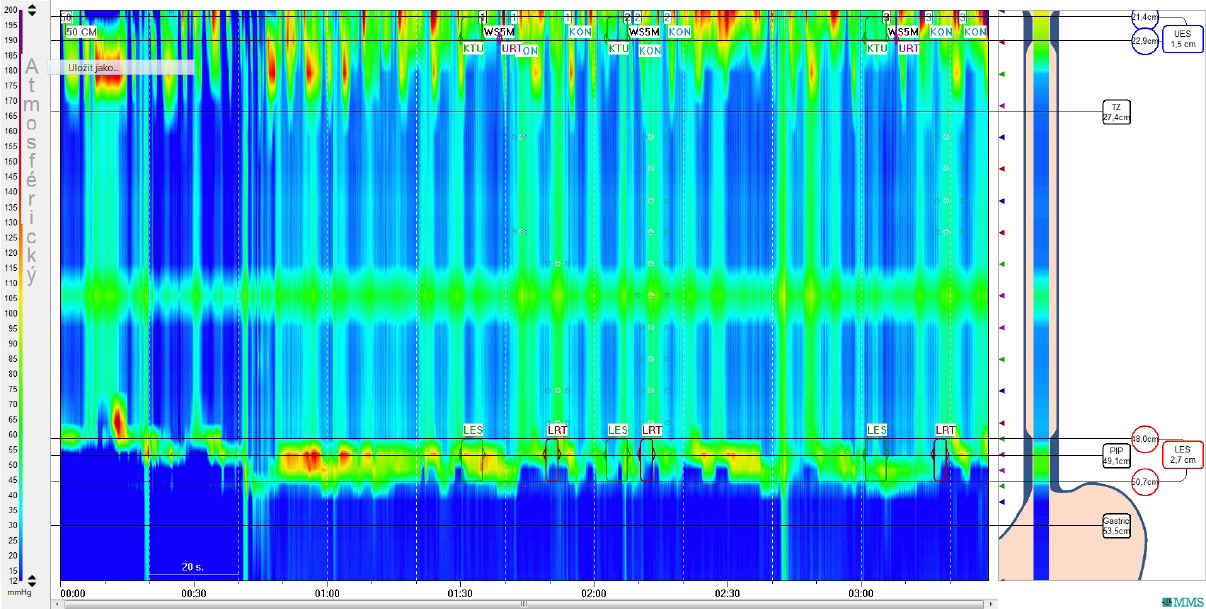
Fig. 1. HRM showing a typical view of achalasia type II – simultaneous contraction and non-relaxing LES during